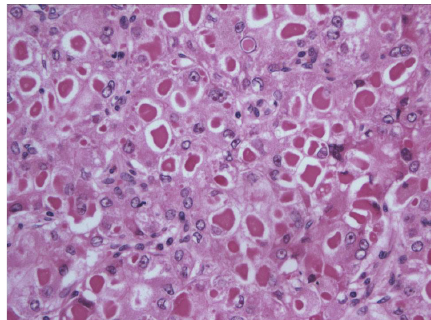
Figure2:Eosinophiliccytoplasmicinclusionswithglobularappear- ance and surrounding clear halo.